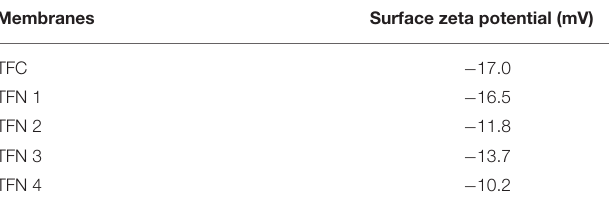
TABLE 2 | Surface zeta potential of pristine TFC and TFN membranes. Membranes